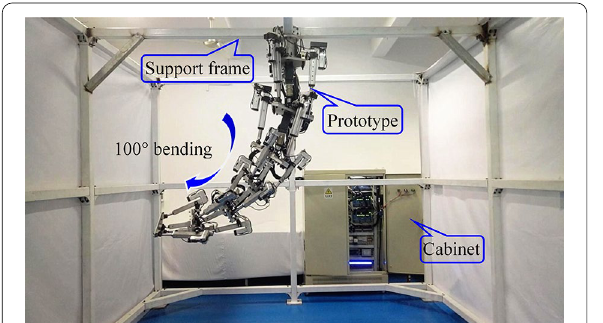
Figure 21 100° bending configuration of HRETR